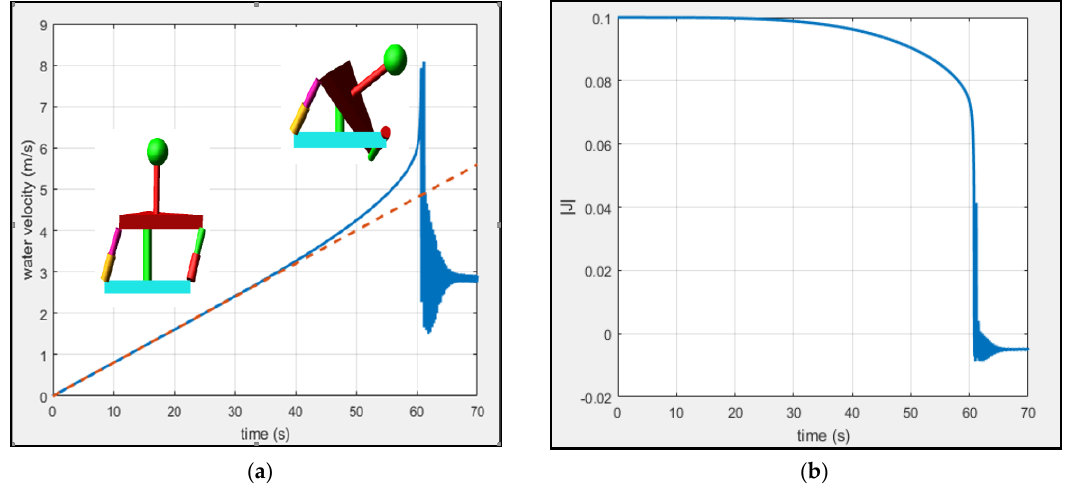
Figure 10. ( a ) The measure range of the sensor. The red line is the input velocity of the water. In this case, the velocity is increasing in a linear form. The blue line is the result of the algorithm. We can see that the sensor response is up to 3.41 m/s. ( b ) The determinant of the Jacobian matrix (see Equation (8)). We can see that thr is zero at 61 s. This means that the parallel mechanism enters into a singularity, failing the sensor, as shown in (a), at 61 s.